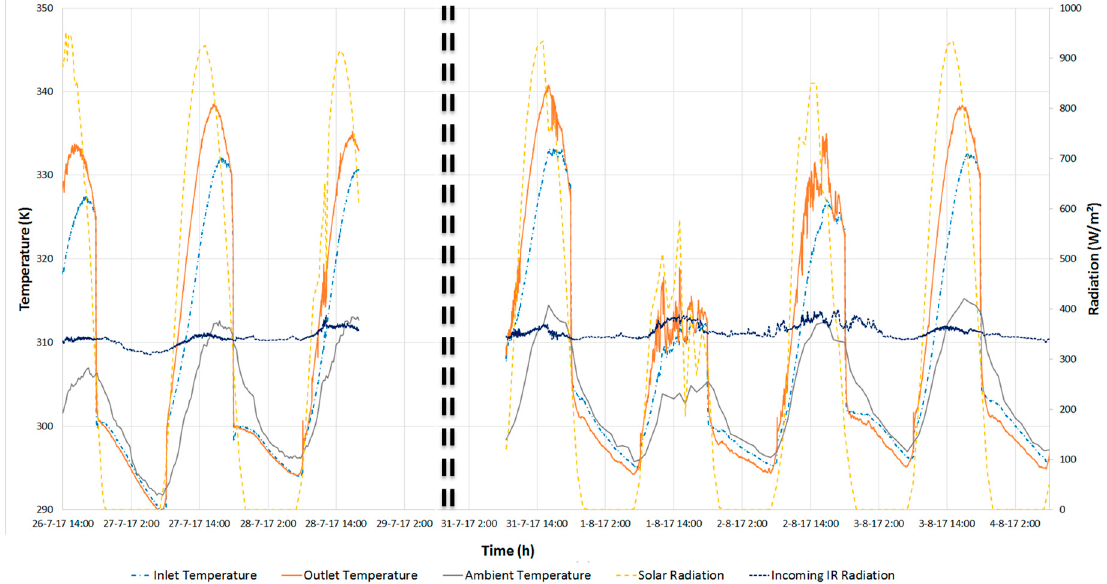
Figure 3. Experimental results of the Radiative Collector and Emitter (RCE) concept.